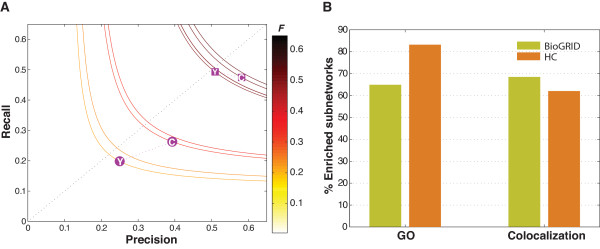
F-measure and biological relevance of predicted complexes using two large-scale PPI networks as inputs. A) F-measures. Circles, F-measures measured against CYC08 (C) or YHTP08 (Y) using the BioGRID network as input. Squares, F-measures measured against CYC08 (C) or YHTP08 (Y) using the HC network as input. B) Fraction of predicted complexes enriched for GO term and colocalization.